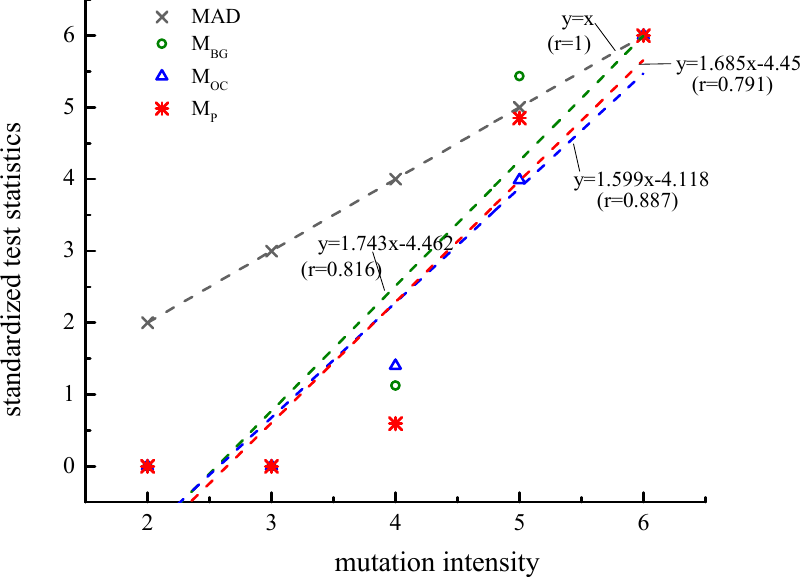
Figure 6. The relationship between the test statistic value of each method and the mutation intensity of each change point.